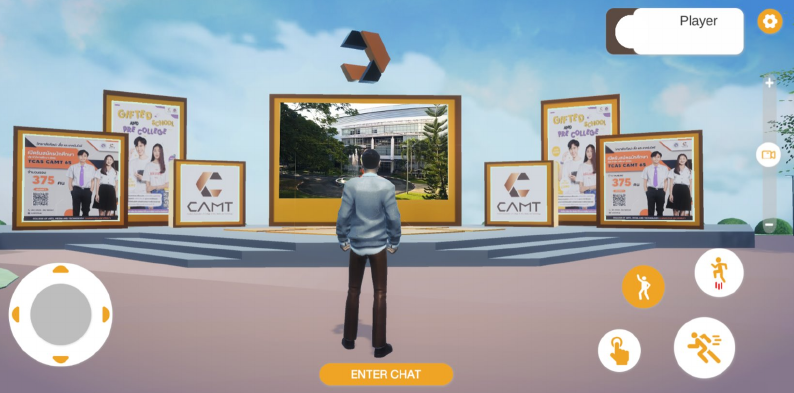
Figure 11. User scores are ranked in the form of a leaderboard, which can be accessed via the Leaderboard function of the metaverse. This feature can encourage users to participate in on- going events.